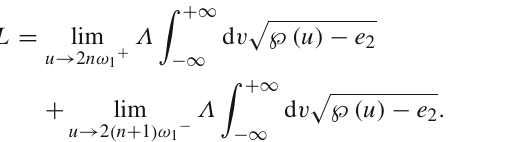
Fig. 6 The coefficient a 0 as a function of the integration constant E for various ω